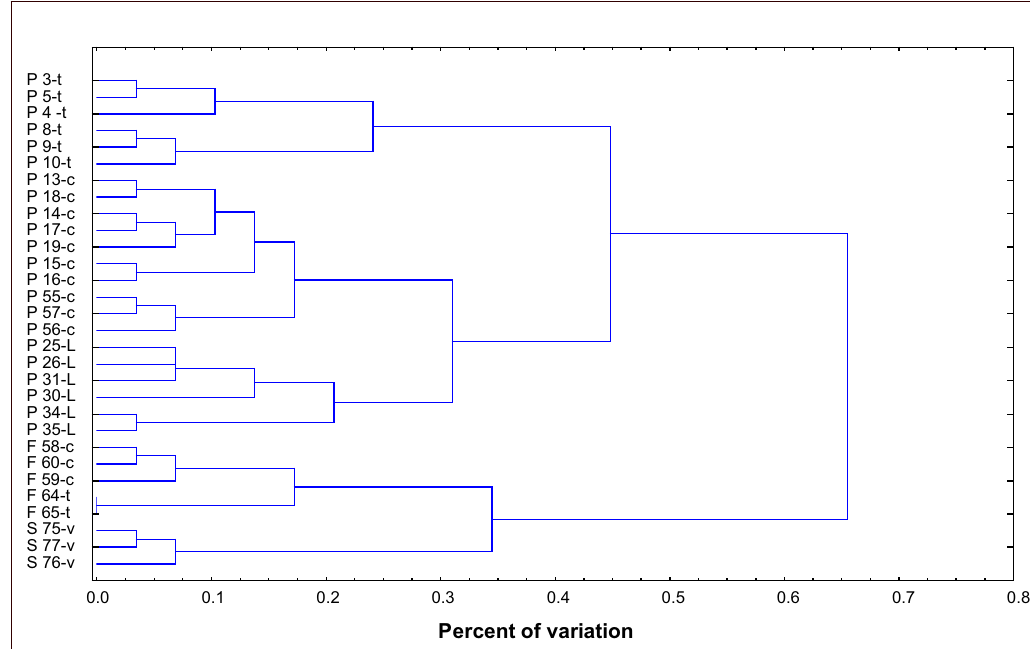
Fig. 1. Dendrogram based on the similarity index matrix of 30 Italian Heterobasidion annosum isolates, after PCR by using the M13 minisatellite as primer. List of isolates see Table